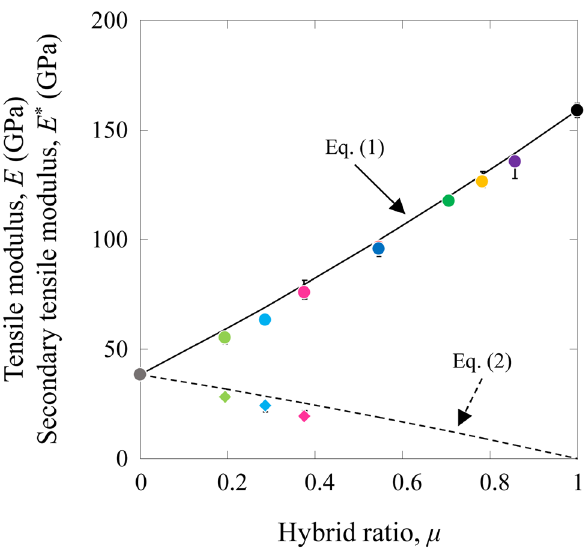
Figure 3. Relation between the tensile modulus and secondary tensile modulus of the HFRP specimens versus the hybrid